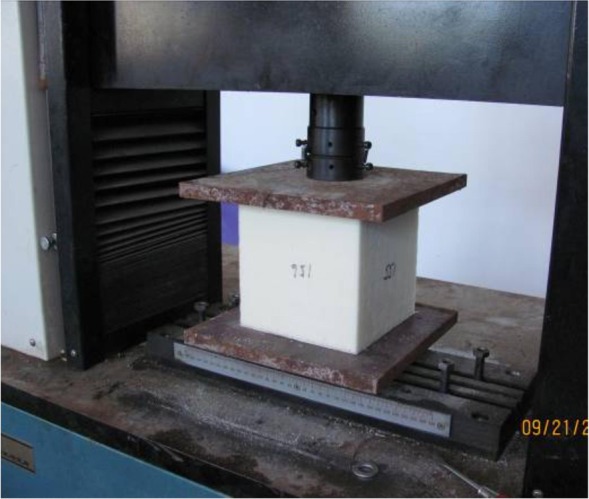
Foam compression test.